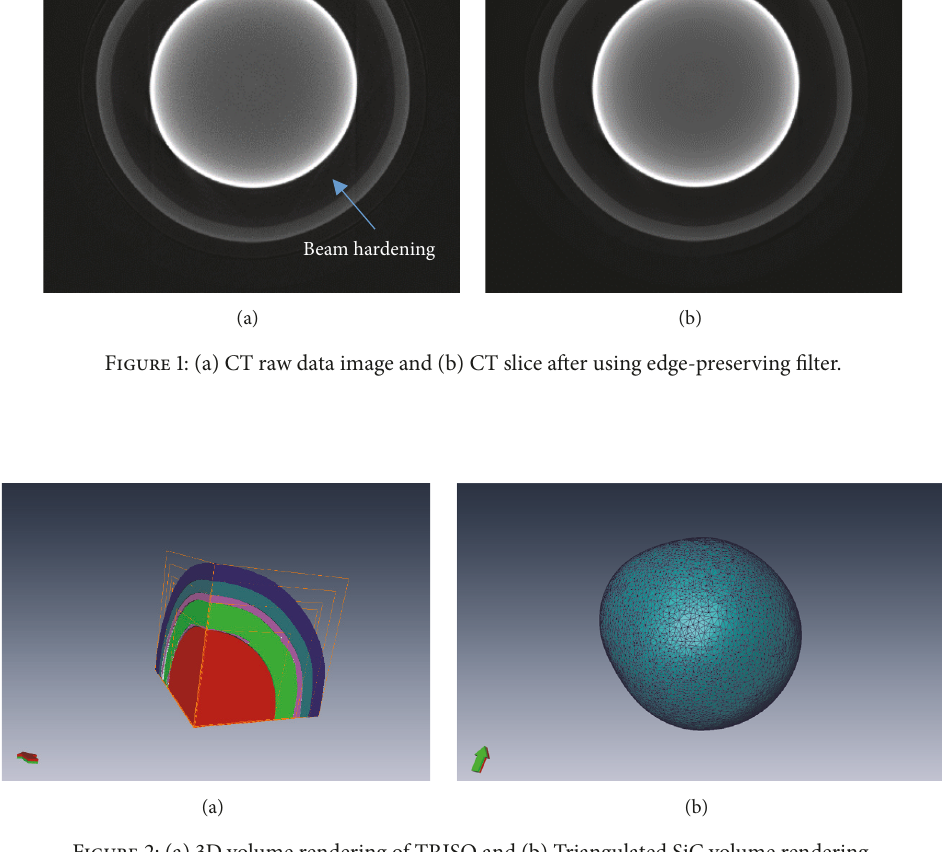
Figure 2: (a) 3D volume rendering of TRISO and (b) Triangulated SiC volume rendering.